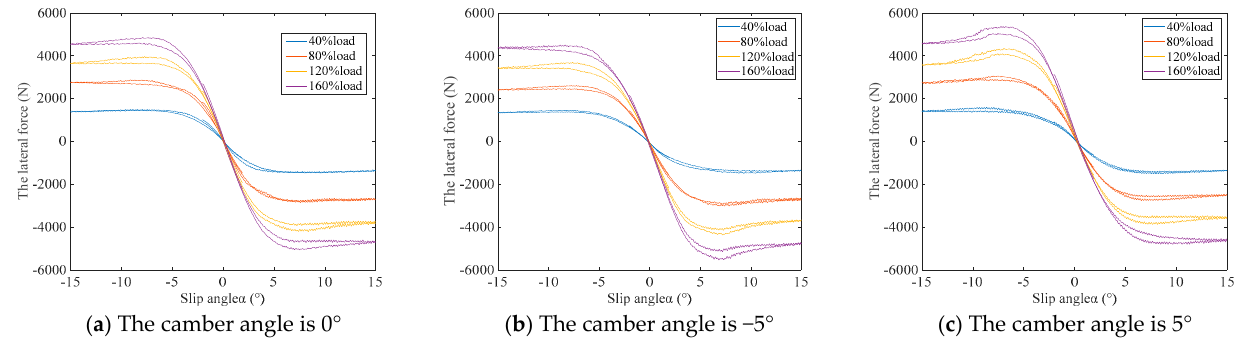
Figure 5. Lateral force experiments with different camber angles.